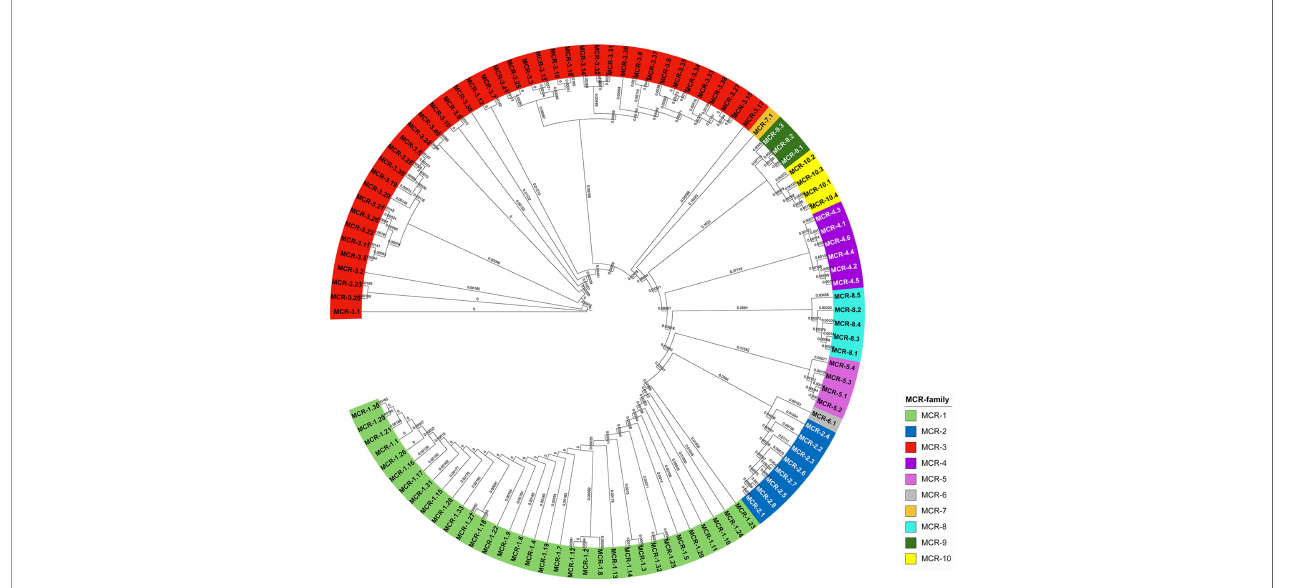
FIGURE 2 | The phylogenetic tree of MCR-gene variants using the Neighbor-Joining method alignment. Multiple sequence alignment was calculated by the clustal omega (Madeira et al., 2019), and the results were illustrated by the Interactive Tree of Life (Letunic and Bork,